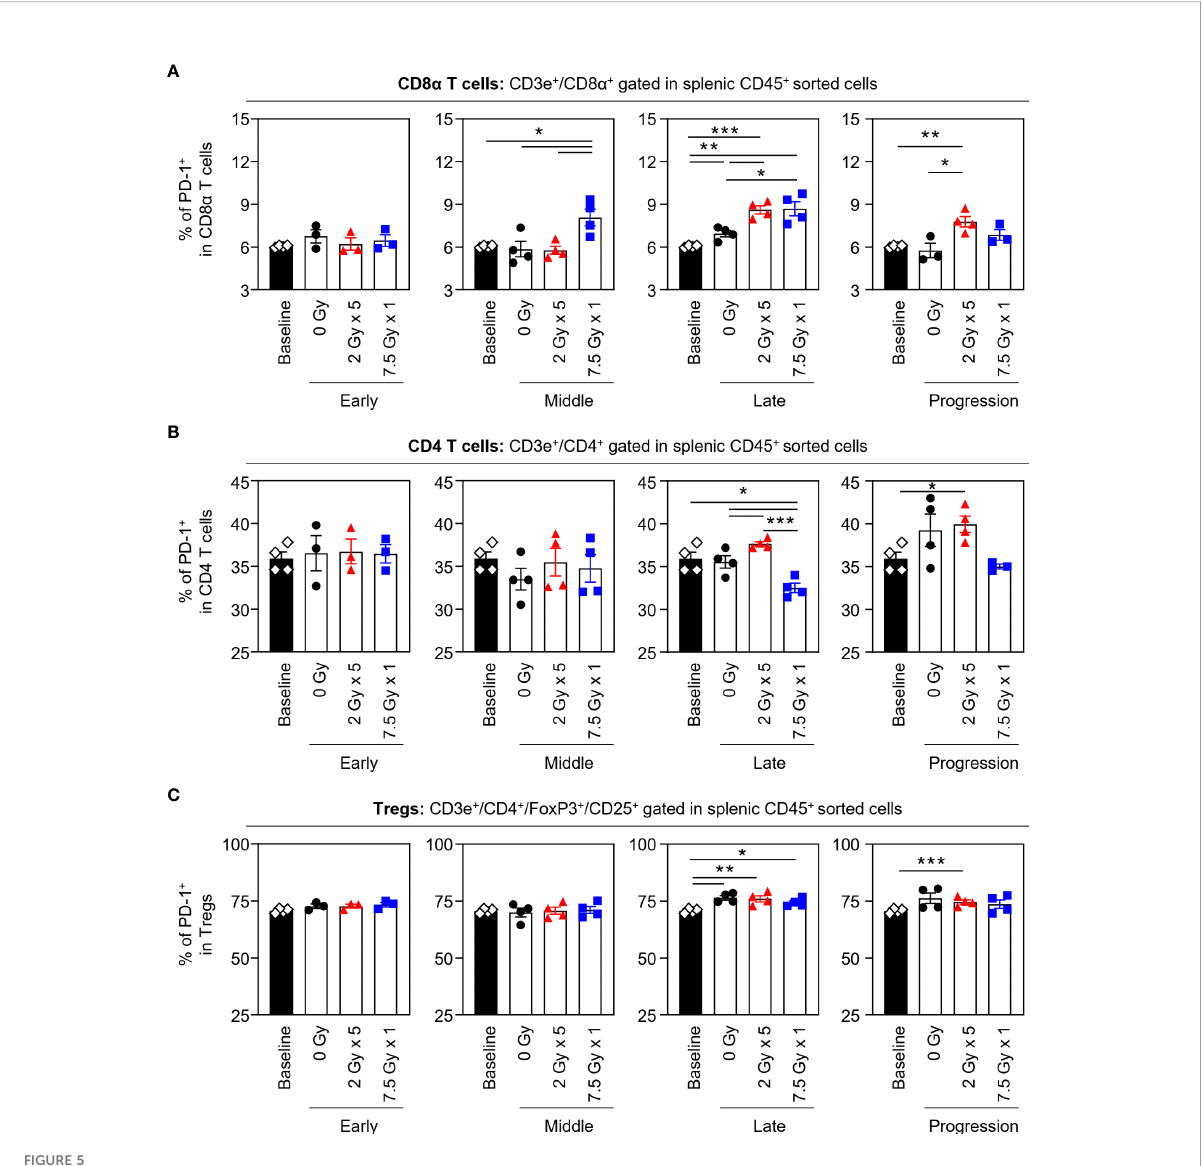
FIGURE 5 Effects of local RT on splenic PD-1 + T-cell subsets. Altered proportions of splenic (A) PD-1 + CD8 a T, (B) PD-1 + CD4 T, and (C) PD-1 + Treg cells for each time phase. All data are presented as mean ± SEM. * P < 0.05, ** P < 0.01, and *** P < 0.001 based on unpaired two-tailed t -test. Results of one-way ANOVA analyses for each time phase are listed in Table S4. These fi gures are based on the representative data obtained from at least two independent experiments. Abbreviations: RT, radiotherapy; PD-1, programmed death-1; Treg, regulatory T; SEM, standard error of the mean; ANOVA, analysis of